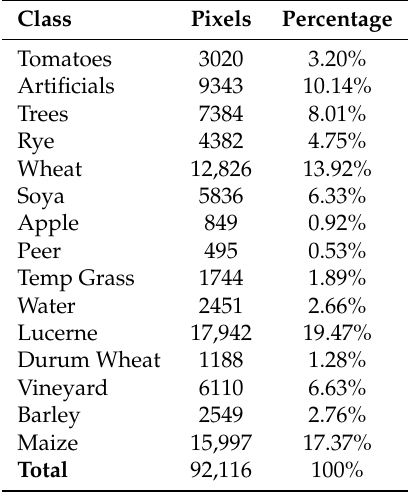
Table 3. Land cover types contribution in the reference